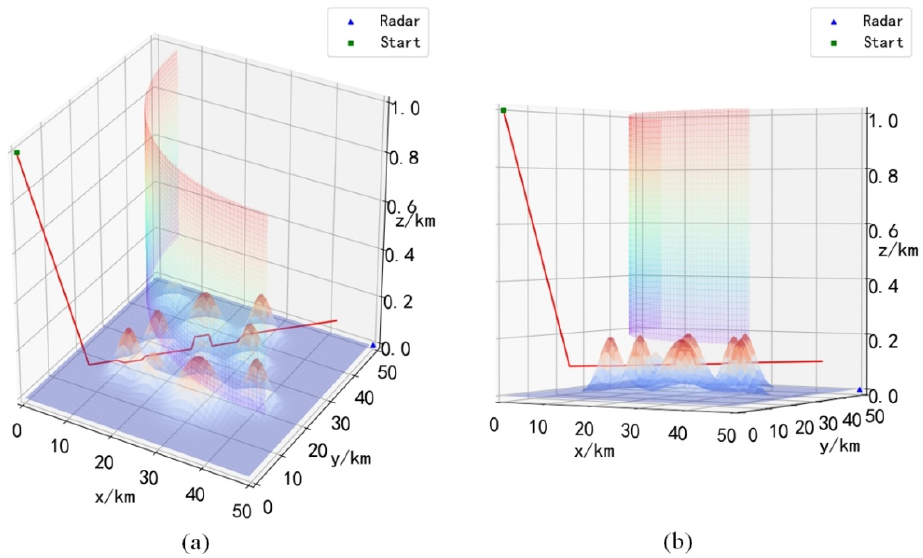
Figure 14. The path planning result in scenario 3. ( a ) is the full view of the path, ( b ) is the side view of the path.